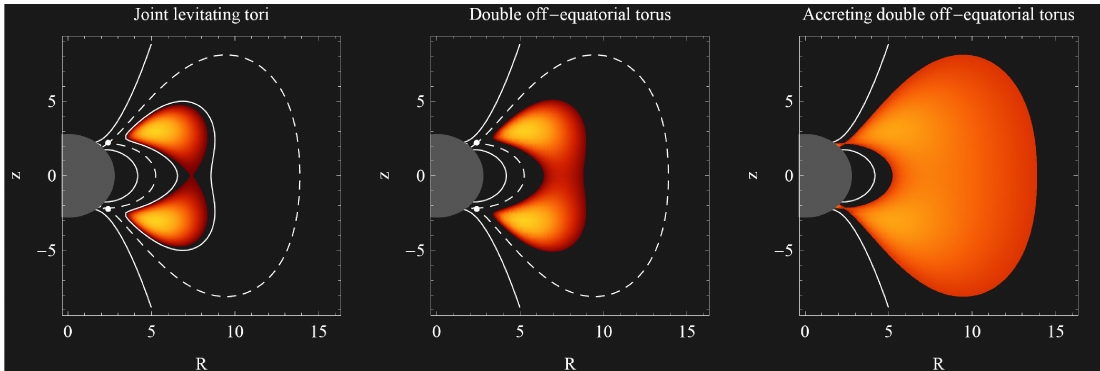
Figure 22. Typical behavior of the potential W for the charged fluid shown in terms of its poloidal profile (left) and poloidal equipotential contours (right). The behavior characterizes circulation of the . . = 2.46 and = = fluid with the (cid:96) , in the dipole magnetic field with 1.17. The self-crossing K A φ M − dot-dashed curve determines the pseudo-critical off-equatorial lobes with equatorial pseudo-cusp, corresponding to the equatorial saddle point, while the twice self-crossing dashed curve determines the critical cross-equatorial lobe with off-equatorial cusps, corresponding to the off-equatorial saddle points; the dots denote locations of the cusps and pseudo-cusp.